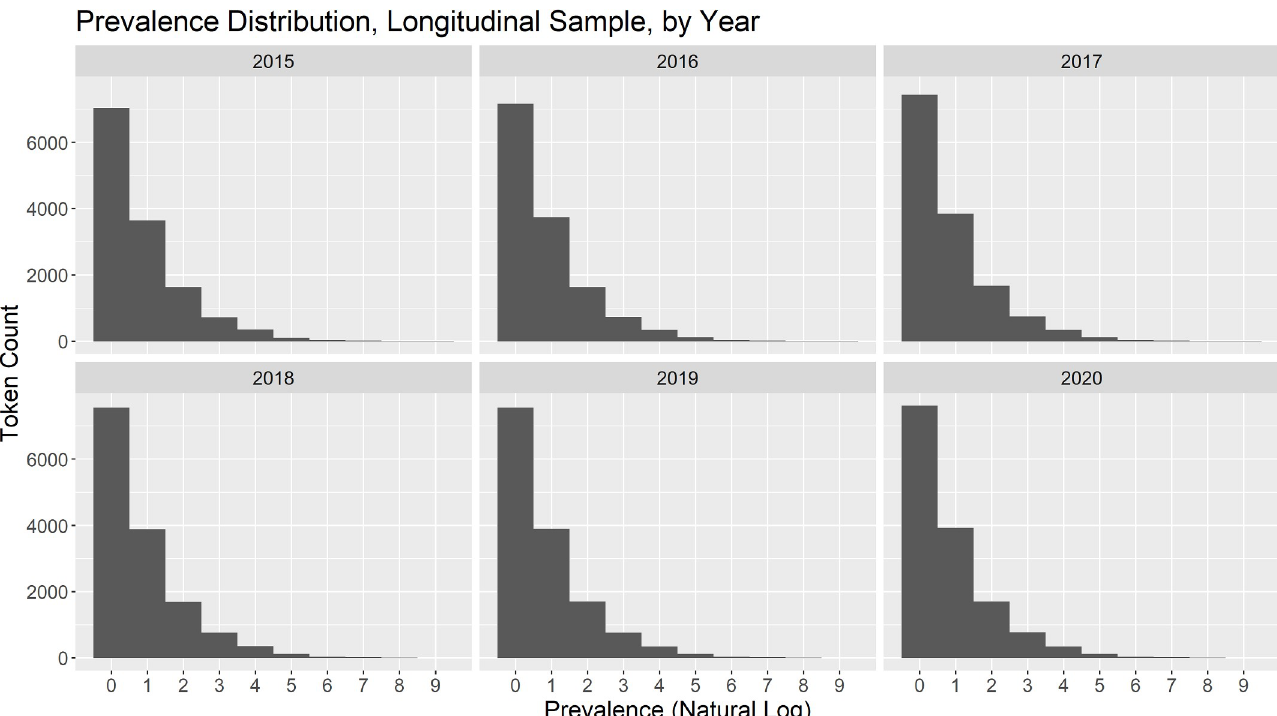
Fig 2. Token prevalence distributions per year for the longitudinal sample. Note that the x-axis is on a log scale. There are a small number of high-prevalence tokens and large numbers of low-prevalence tokens. This accords with general expectations of word usage.